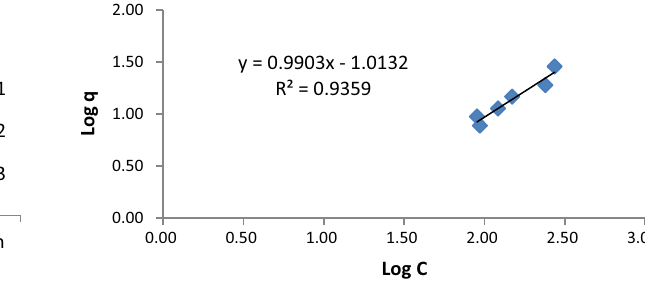
Fig. 14 Freundlich isotherm of spent tea waste